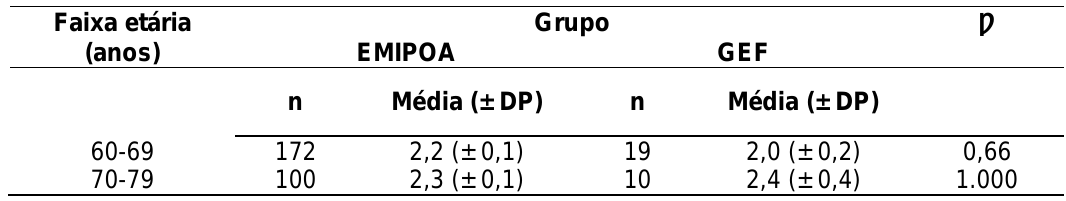
Tabela 1. Comparação do alinhamento corporal apresentado por idosas participantes do EMIPOA e praticantes de exercícios físicos na Ação Comunitária na